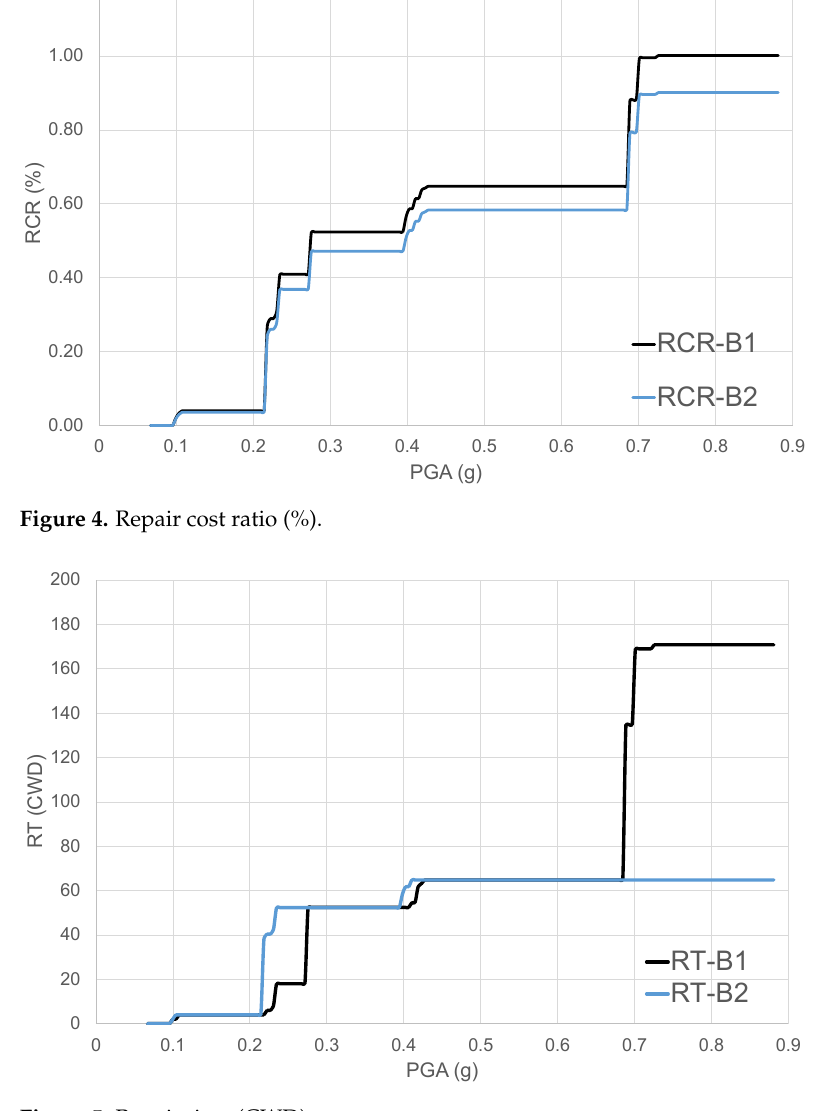
Figure 5. Repair time (CWD).